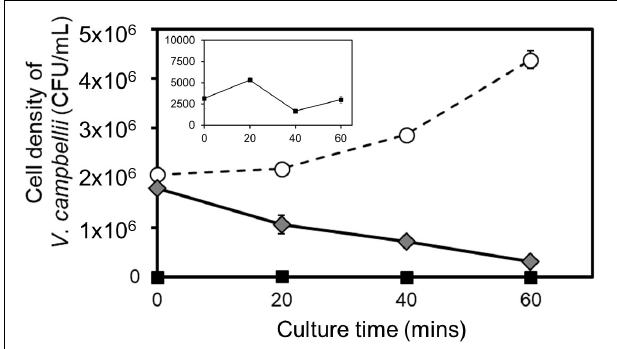
FIGURE 6 | Bacterial clearance by Strombidium spp. NTOU1. Black squares (also shown in the inset using an adjusted scale for clarity) indicate the number of bacteria in the aerated seawater as the background controlled group. White circles indicate the cell density of V . campbellii cultured alone. Gray diamonds represent the bacterial density after 5,000 cells/mL of ciliates were added. The error bar represents the S. D. of the average from three independent experiments.